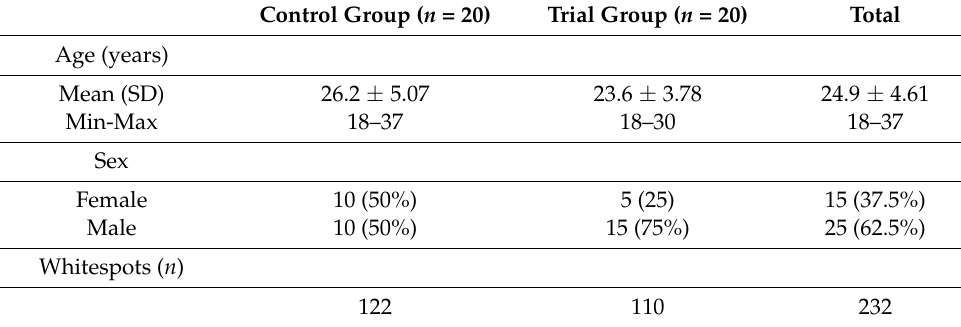
Table 3. Baseline demographic characteristics .